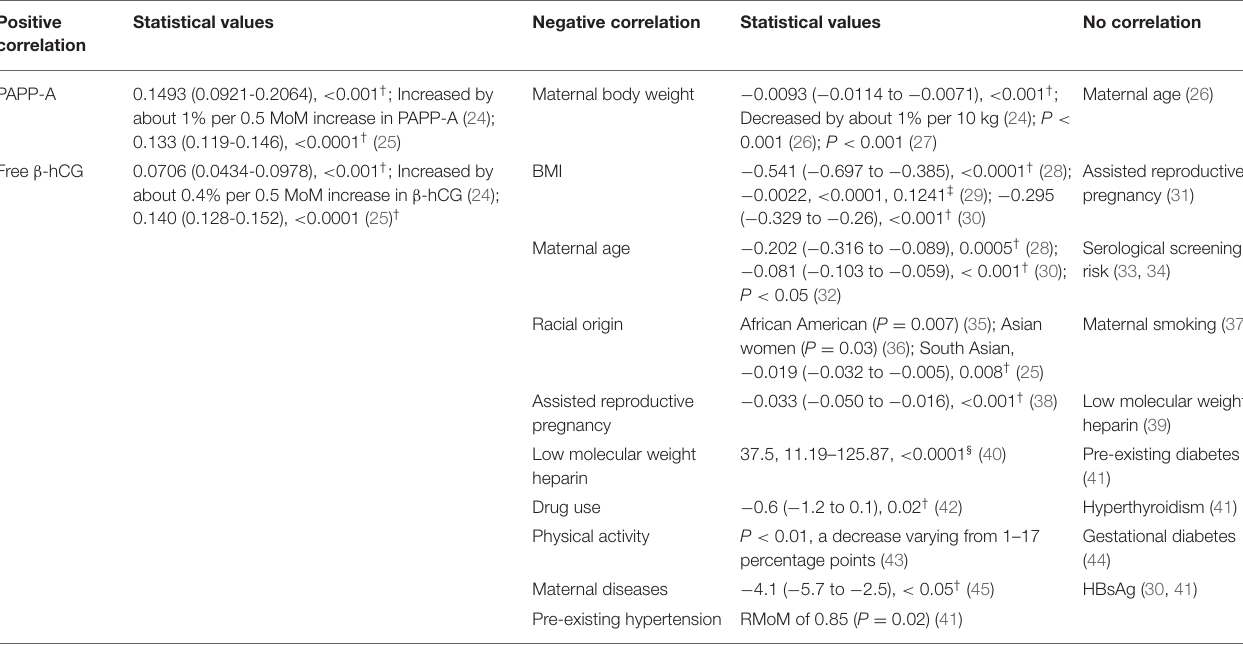
TABLE 1 | Maternal factors that affect fetal fraction of circulating